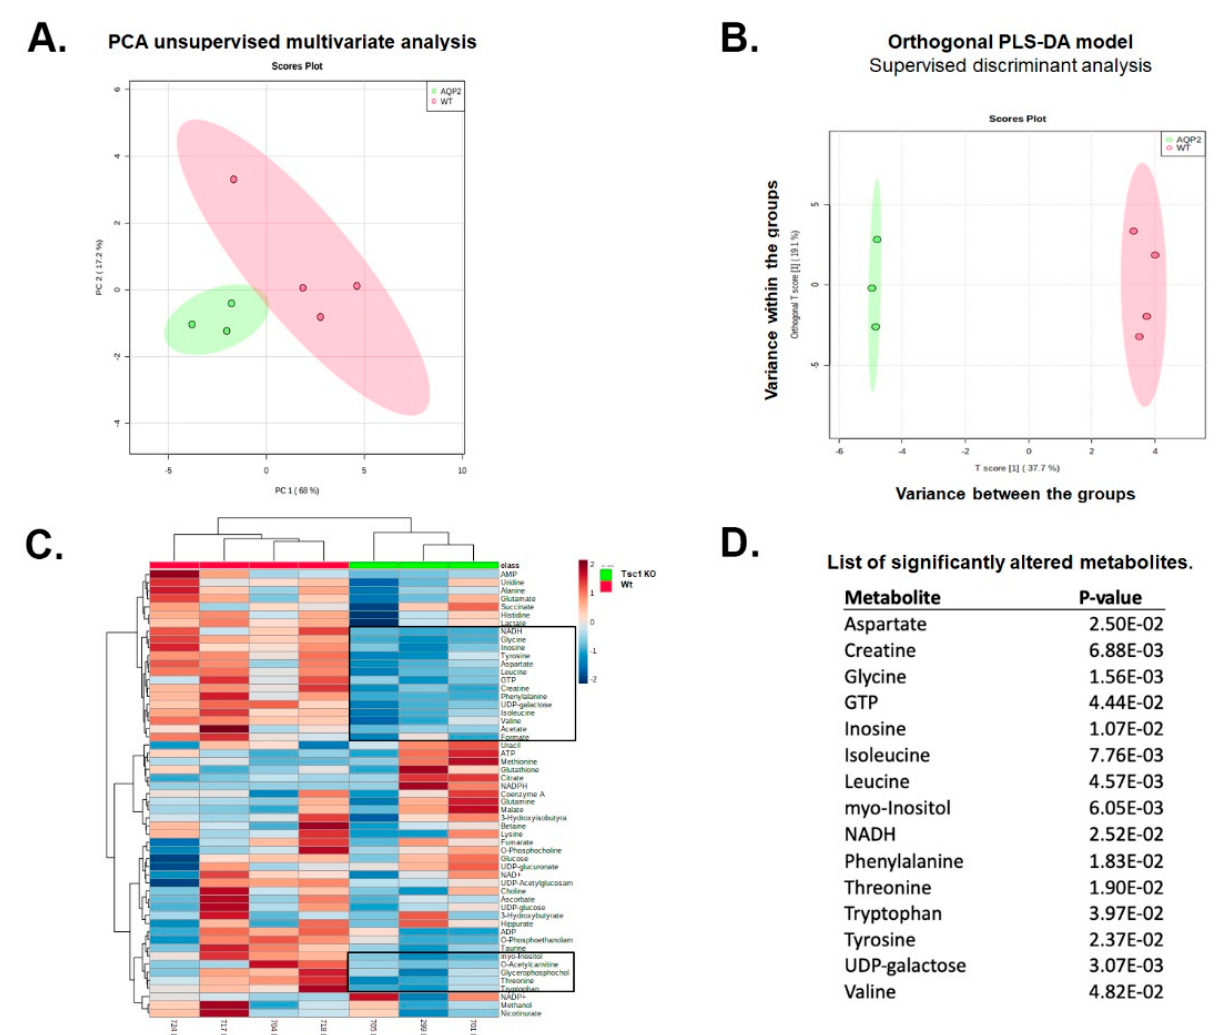
Figure 2. Analysis of 1 H NMR spectroscopic data. Intrinsic variations within and between the kidneys of Wt and Tsc1 KO mice were determined by ( A ) unsupervised PCA method demonstrating the magnitude of variation present in-between the groups and ( B ) supervised OPLS-DA analyses showing the separation between the kidney extracts of Wt and Tsc1 KO mice. Both ( A , B ) demonstrated a strong clustering within and significant separation between the test samples. ( C ) Metabolite heat maps of Wt and Tsc1 KO revealed significant changes in their metabolomes, the two bracketed areas represent the metabolomes that are significantly changed. Boxes have been drawn around the significantly altered metabolites. ( D ) List of significantly altered metabolites.